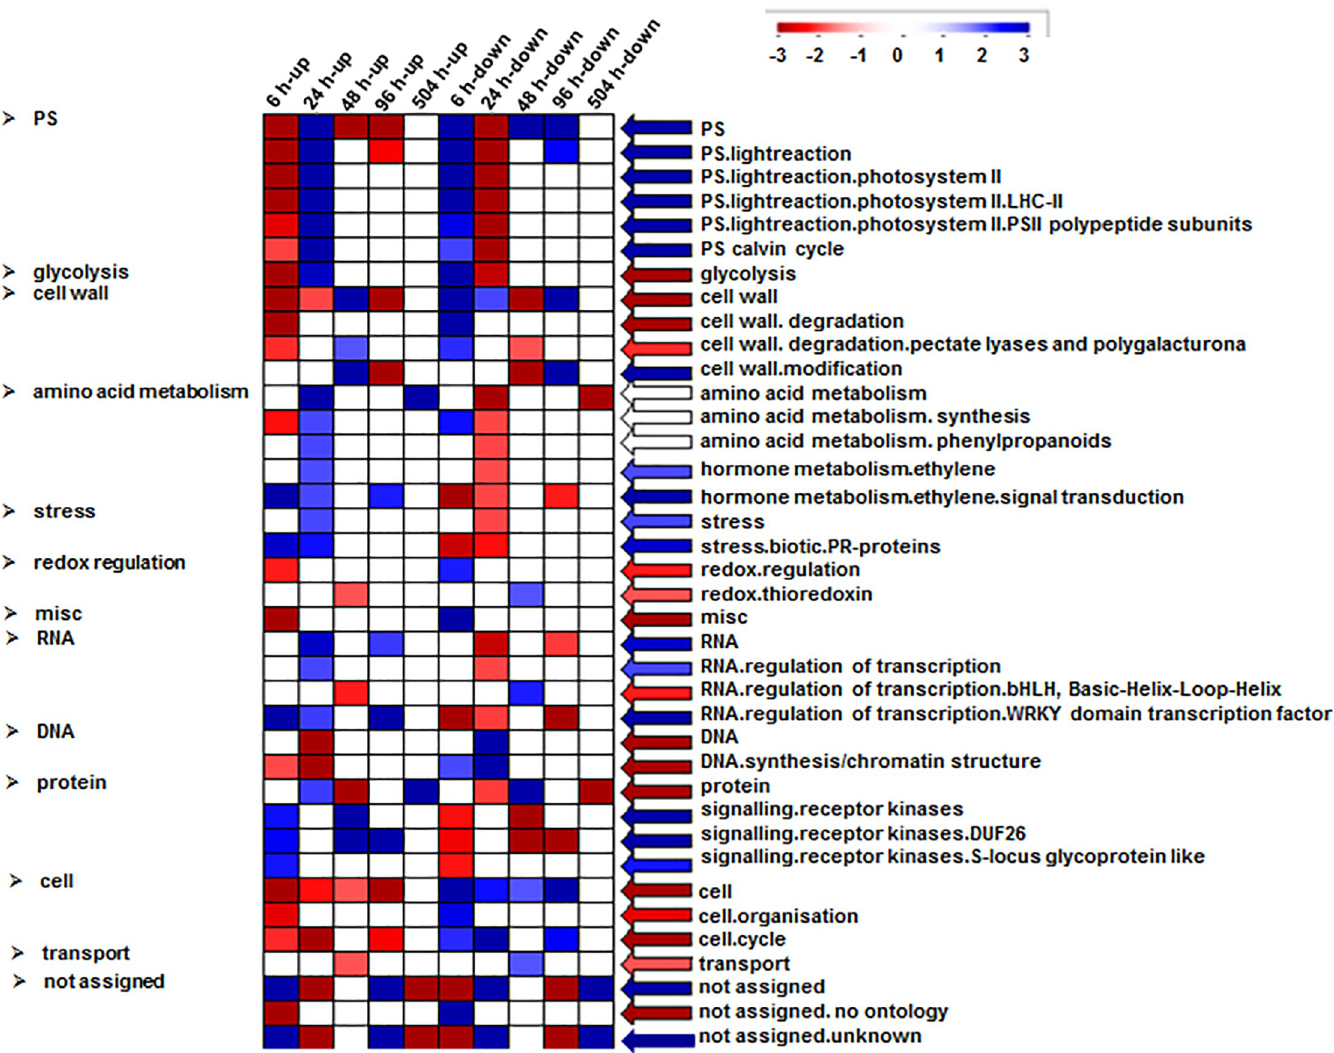
Fig 1. PageMan display of significantly represented functional categories across different time points in response to PEG treatment. Differentially expressed genes (DEGs) for various time points displaying significant up- and down-regulation were used for the analysis (see materials and methods). The data were subjected to a Wilcoxon test, and the results are displayed as blue-colored bins (significantly over represented), red-colored bins (significantly under represented) and white-colored bin (not significant). Arrow at right side of heatmap represents average level of significance for all the time points. In the figure, non-significant categories have been collapsed to display only significant functional categories. The main functional categories are displayed in the left whereas specific sub-categories are shown in the right.